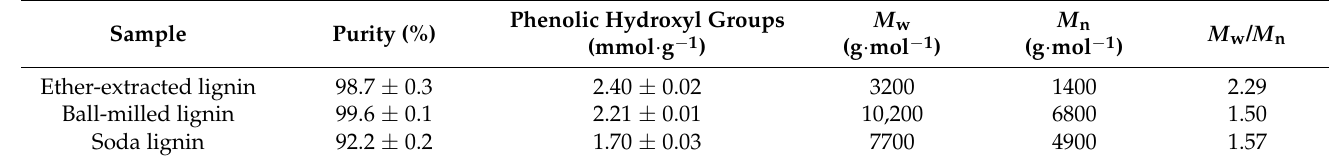
Table 2. The chemical composition of rice straw before and after the absolute ethanol extraction, pretreatment, and enzymatic